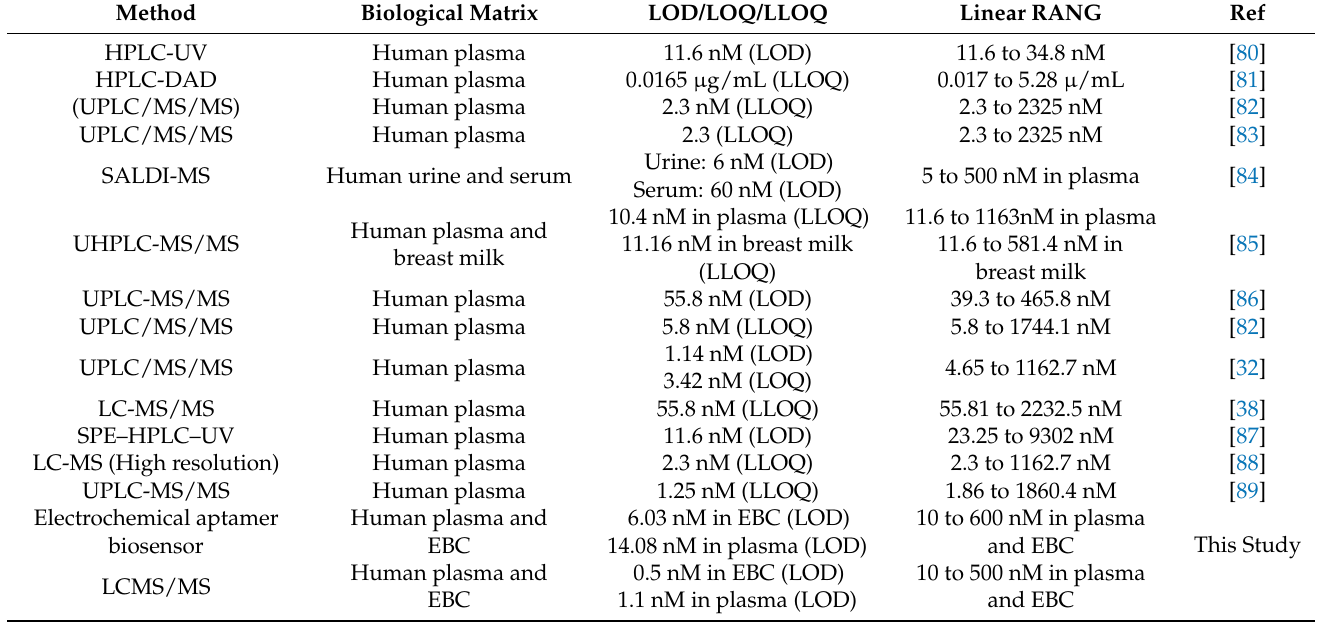
Table 1. Analytical figures of merit of previously developed methods toward determination of RIV in biological